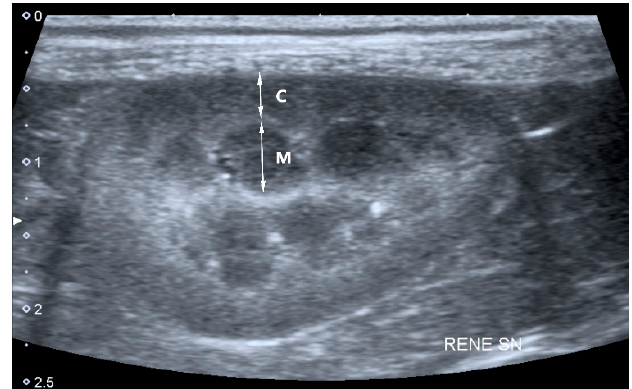
Figure 1. Sagittal plane of the left kidney of a 10-year-old dog with chronic kidney disease for the measurement of the cortical and medullary ratio (C/M ratio): cortical thickness (C) was measured over a medullary pyramid, perpendicular to the capsule; medullary thickness (M) was measured from the renal hilum to the outer margin of the cortico-medullary junction. In this dog the C/M ratio was 0.64.